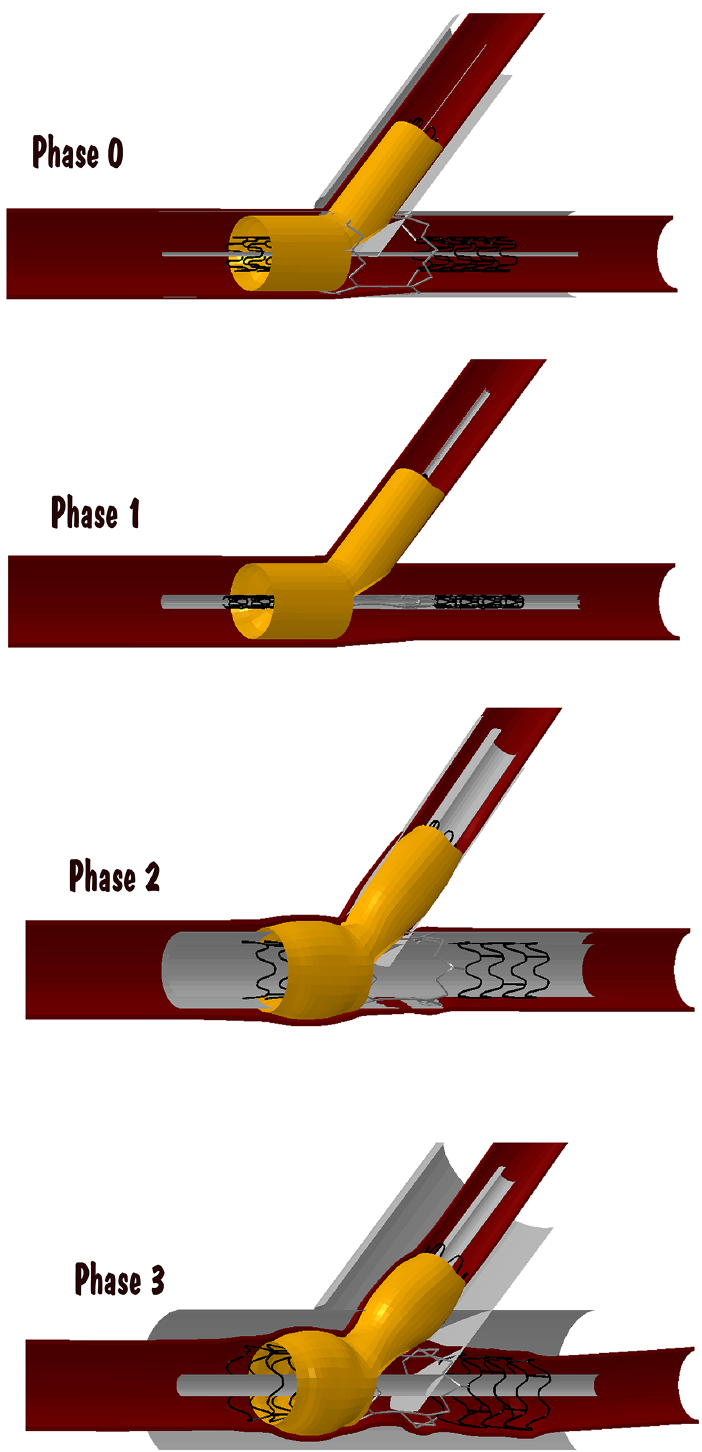
Fig 3. Describes the phases (phase 0 to 3) of deployment of the stent. Description of details of deployment given in text.